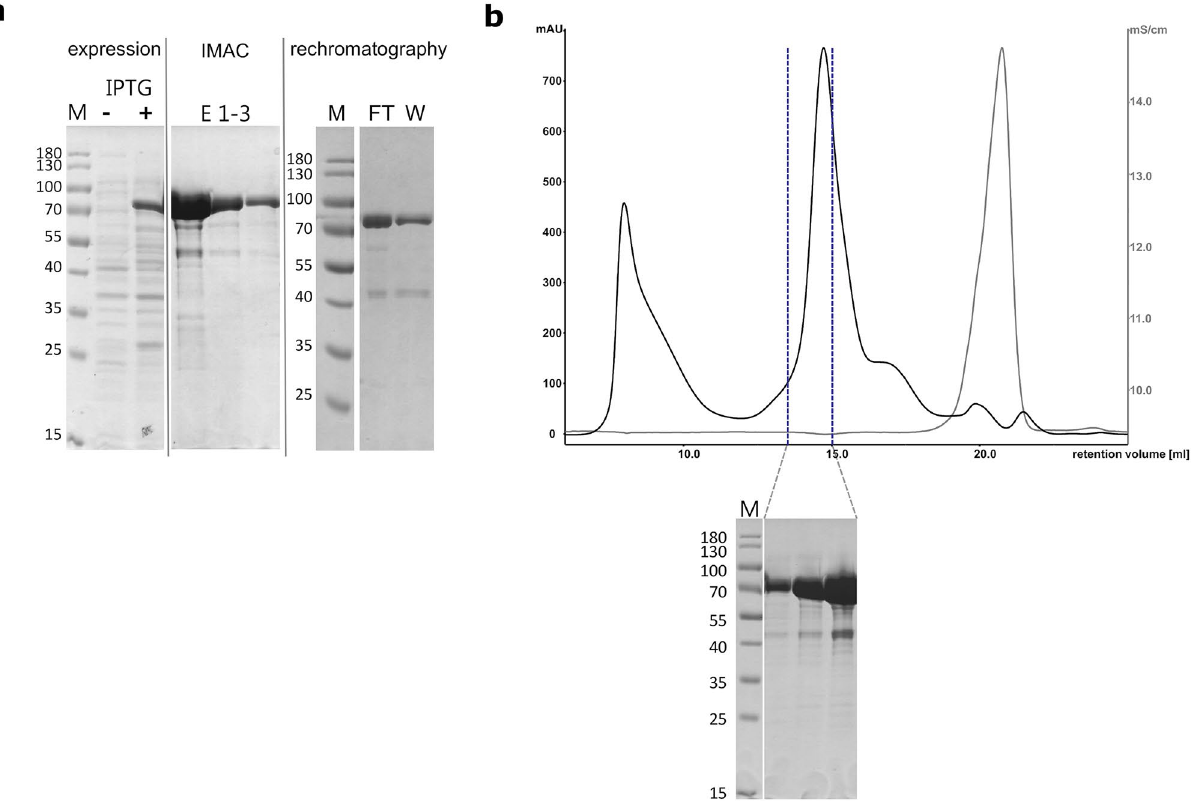
Figure 2. Representative purification of ColQ1 CU ( a ) Expression, IMAC and removal of His 6 -tag. M: molecular weight standards, IPTG ∓ : total cell lysate before induction and at time of harvest, E1-3: elution with 250 mM imidazole, rechromatography FT (flow-through) and W (wash): fractions containing target protein after His 6 -tag cleavage by TEV-protease. ( b ) Size exclusion chromatography and SDS-PAGE of pure protein fractions. The blue dotted lines indicate the fractions that were analysed in the depicted SDS-PAGE gel and subsequently pooled for further use. M: molecular weight